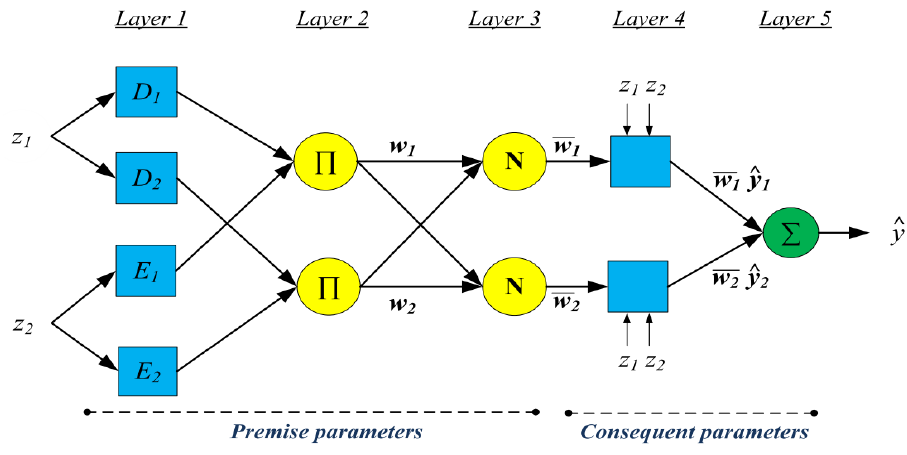
Figure 2. Basic ANFIS diagram.